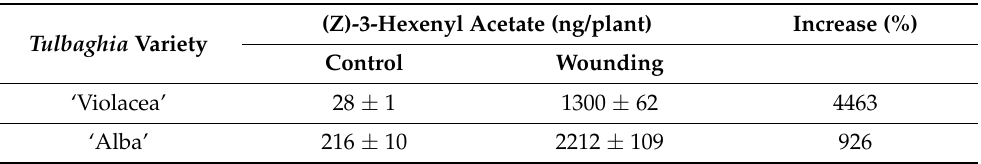
Table 4. Semi-quantitative determination of (Z)-3-Hexenyl acetate emitted after wounding by whole plants of white-flowered and purple flowered T. violacea (ng/plant in 5 h). (Z)-3-Hexenyl Acetate (ng/plant) Increase (%) Tulbaghia Variety Control Wounding ‘Violacea’ ‘Alba’